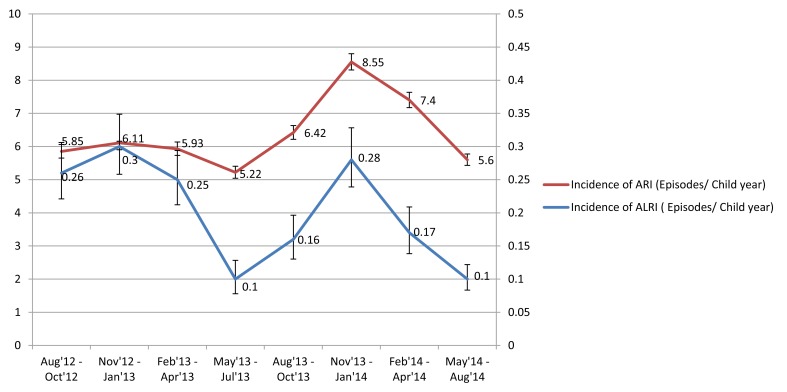
Seasonal variation in incidence rates of acute respiratory infection and acute lower respiratory infection among study children in Ballabgarh, northern India, 2012-14. ARI – Acute respiratory infection, ALRI – Acute lower respiratory infection.